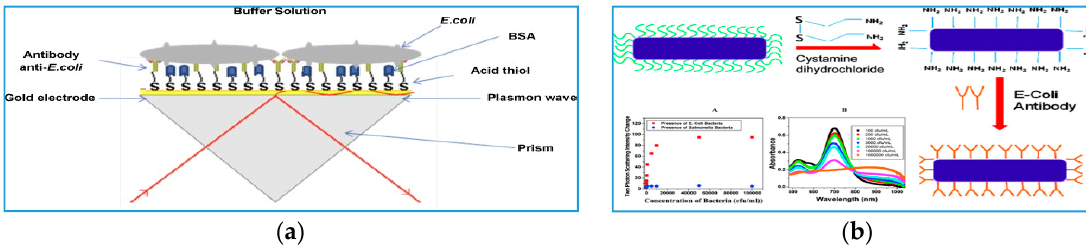
Figure 7. Examples of E. coli immunosensors using: ( a ) AuNPs with SPR quantification (adapted with permission from [14]) and ( b ) Au nanorods and two-photon Rayleigh scattering (TPRS) spectroscopy as a detection technique. Adapted with permission from [18]. Copyright (2009) American Chemical Society.